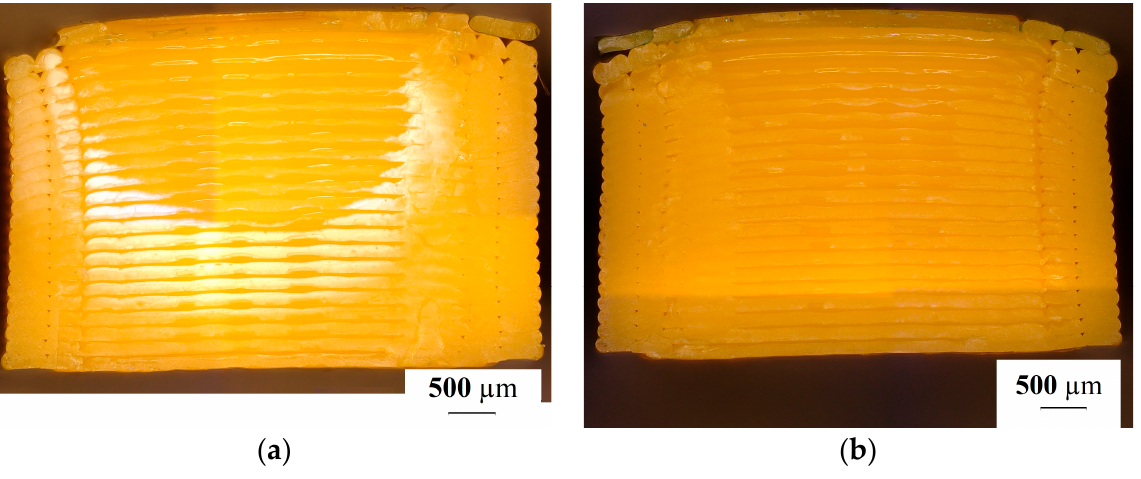
Figure 8. The ruptured surface of the vertically printed test specimens after the tensile test. ( a ) A specimen that did not undergo heat treatment; ( b ) specimen heat-treated at 65 °C.